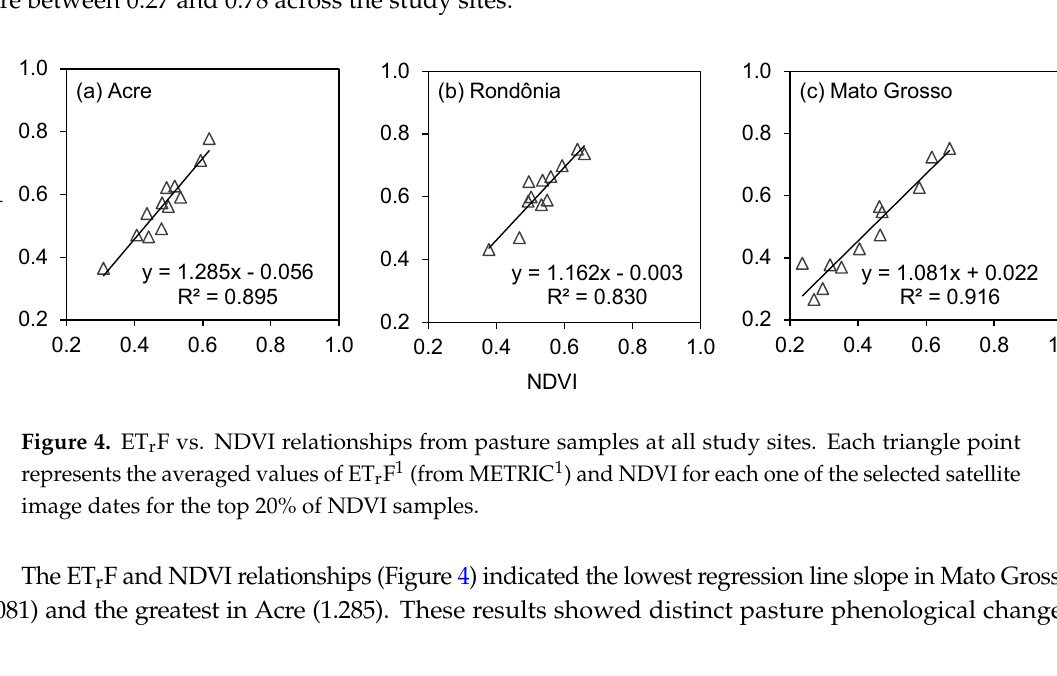
2009). At Rond ô nia, NDVI varied from 0.38 (DOY 231, 2001) to 0.66 (DOY 162, 2002), and between 0.24 were between 0.27 and 0.78 across the study sites.